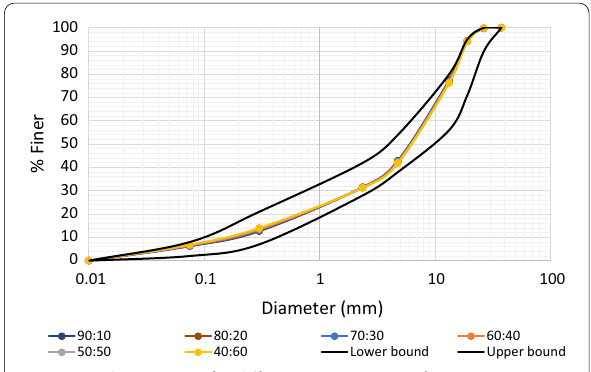
Fig. 3 Gradation curve for different percentages of